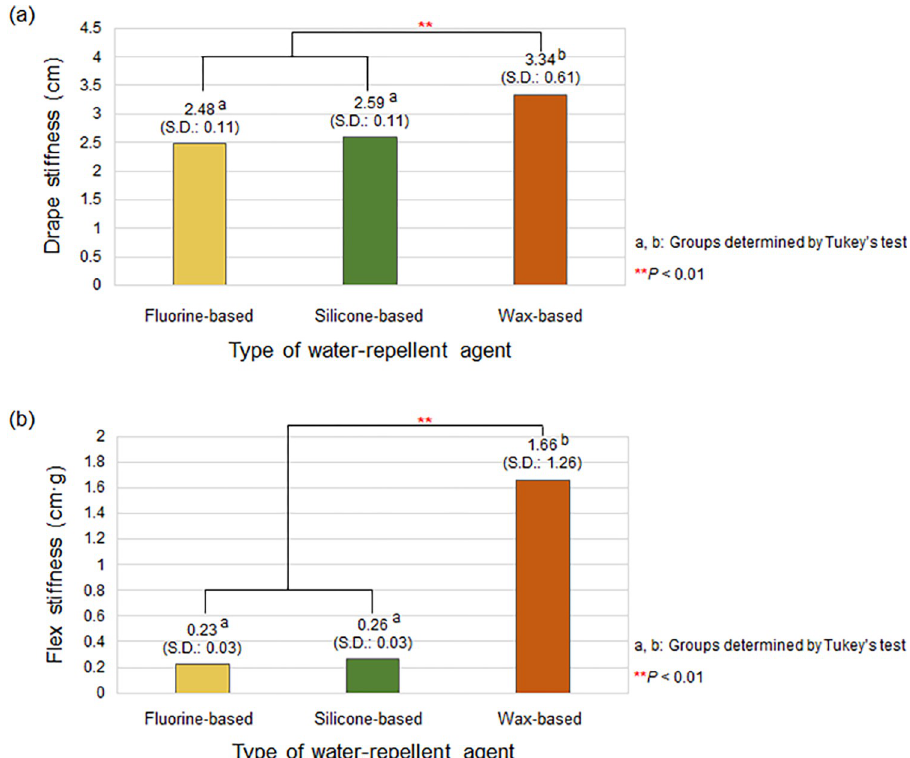
Fig 3. Stiffness of the cotton woven fabric according to the type of water-repellent agent: (a) drape stiffness and (b) flex stiffness. The result is the average stiffness of the fabrics of all numbers of coating layers under each water-repellent agent